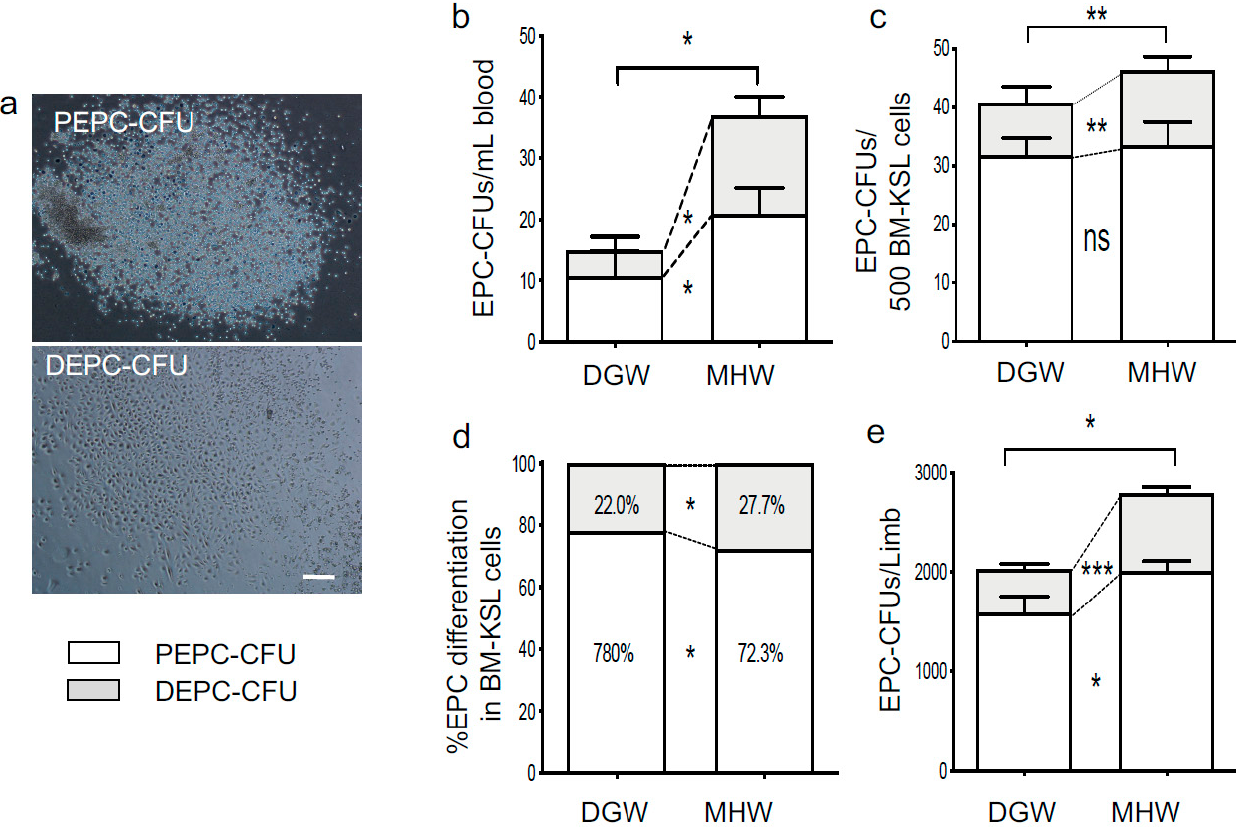
Figure 7. The biological properties of EPCs in DIO mice treated with DGW or MHW for 14 days. ( a ) Representative images of pEPC-CFUs and dEPC-CFUs in methylcellulose culture medium. ( b – e ) The counts and differentiation degree of EPC-CFUs between the DGW and MHW groups. EPC-CFU counts per mL blood ( b ), originated from 500 BM-KSL cells ( c ), originated from whole BM-KSL cells in the left femur and tibia ( e ). ( d ) The EPC differentiation degree calculated using the ratio of dEPC-CFUs/total EPC-CFUs (pEPC-CFUs + dEPC-CFUs) in ( c ). The clear and gray columns indicate pEPC-CFUs and dEPC-CFUs, respectively; ns, not significant; * p < 0.05, ** p < 0.01, *** p < 0.001.